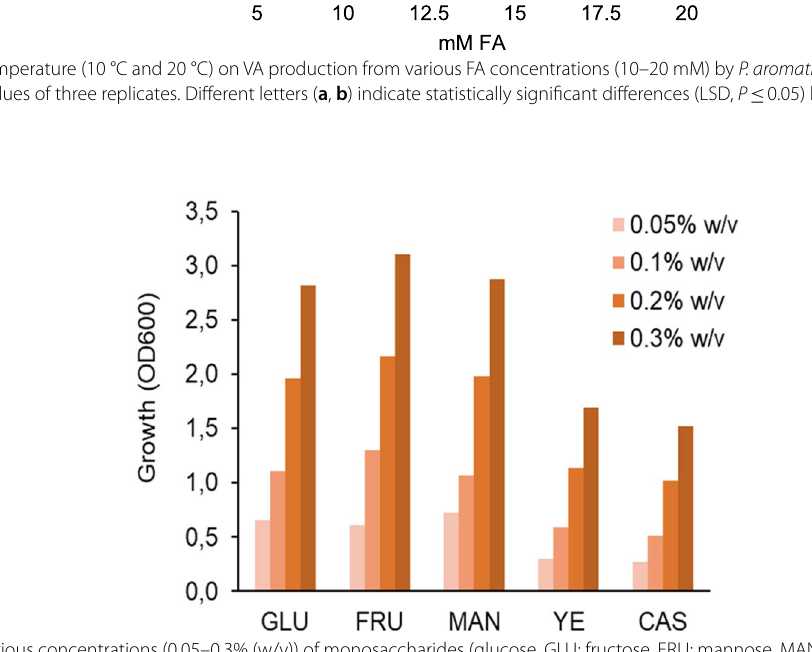
Fig. 5 Effect of various concentrations (0.05–0.3% (w/v)) of monosaccharides (glucose, GLU; fructose, FRU; mannose, MAN), casamino acids (CAS), and yeast extract (YE) on biomass production by P. aromaticivorans AR20-38 at 20 °C. Data represent mean values of three replicates (SDs <